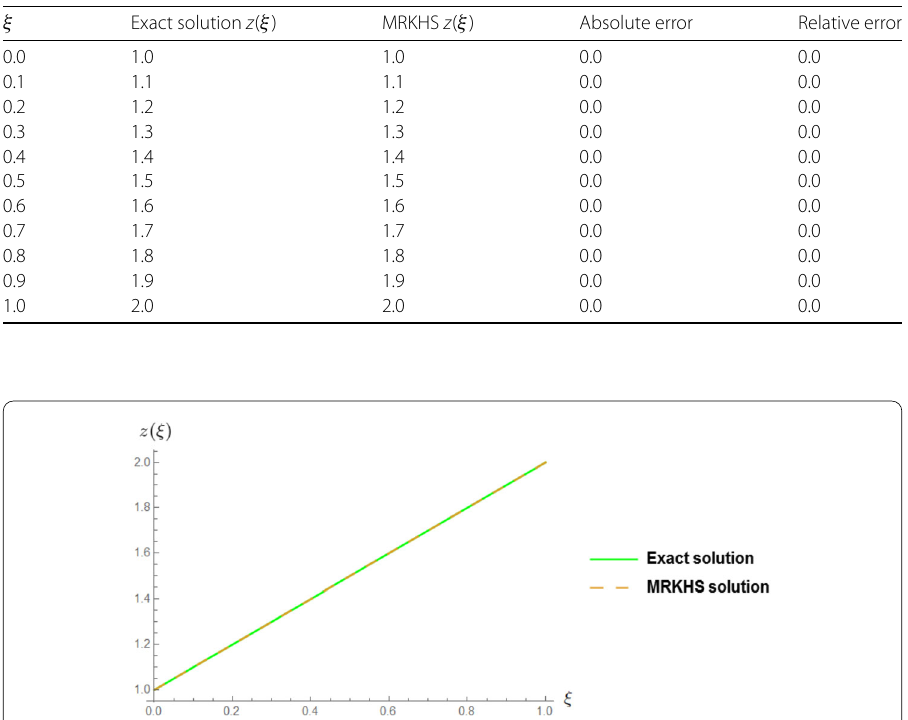
Table 2 Numerical results for Example 5.2